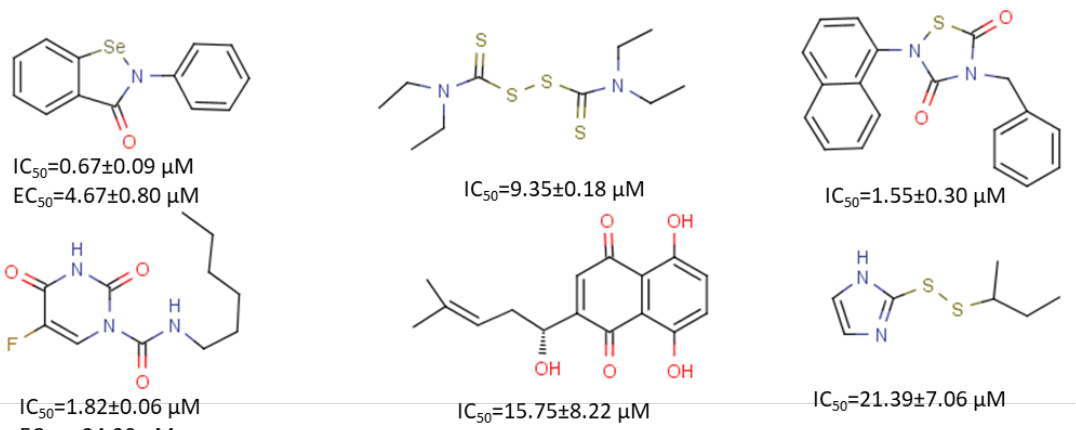
Figure 6. Compounds identified through high-throughput screening. Structures, half maximal inhibitory concentration values/ half-maximal effective concentration (IC 50 s/EC 50 s) (when applicable) of compounds are shown. Please refer to [54] for more details.